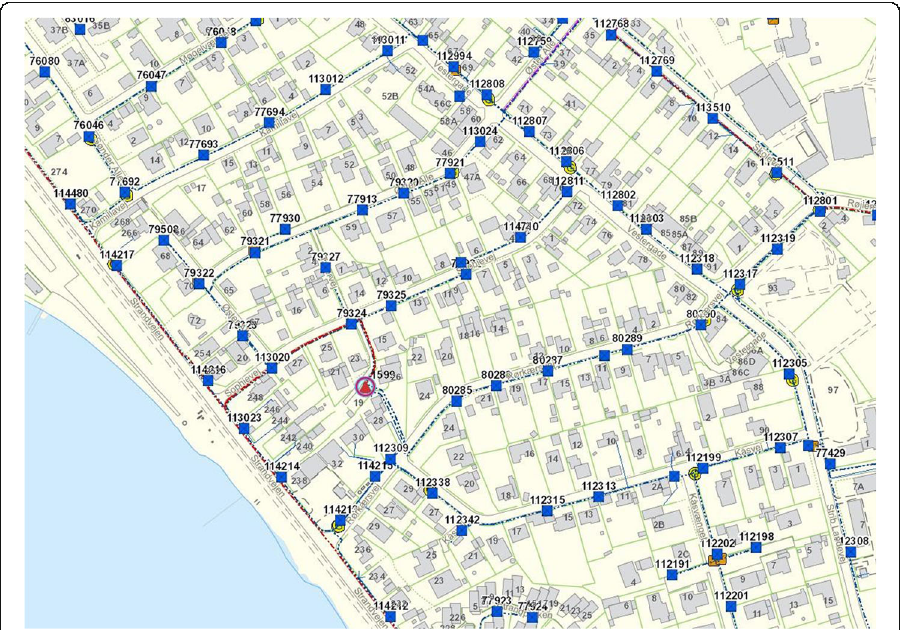
Fig. 9 Map of the chosen low-voltage grid (Note: The blue squares are switch boxes; the red triangle is the